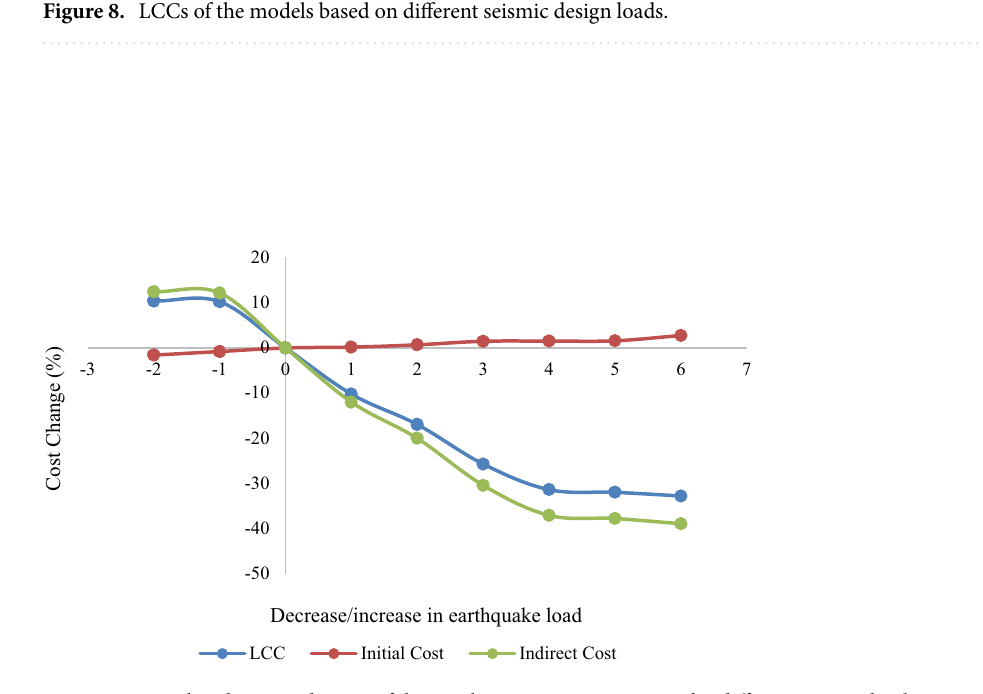
Figure 9. Initial, indirect, and LCCs of the regular 7-story structures under different seismic